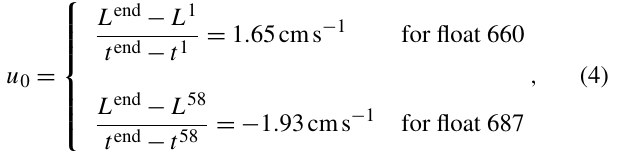
wave. Note that v 0 is the amplitude A Te of the Eulerian the- oretical wave. By convention, the subscript “T” is used for theoretical, “M” for measured, “e” for the Eulerian descrip- tion of the wave and “ (cid:96) ” for the Lagrangian one (Table 2). After performing some tests (Appendix A), we choose to set the zonal velocity of the floats as the global mean velocity of the float